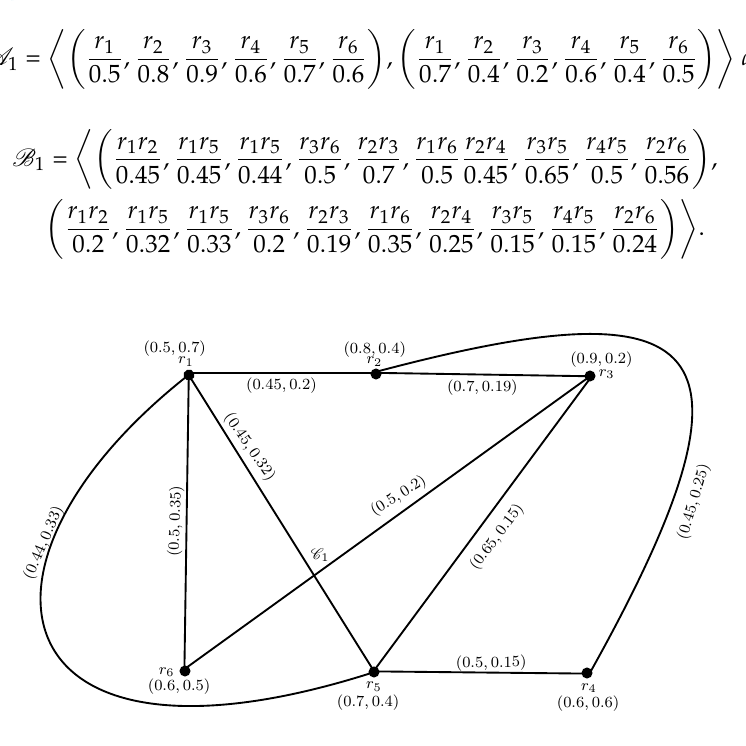
Figure 6. PFPG with one crossing. Figure 3.3: PFPG with one crossing